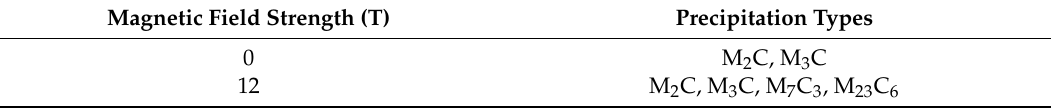
Table1. Thecarbidetypesformedduringtemperingat823Kfor1hwithandwithout12Tmagneticfield. Magnetic Field Strength